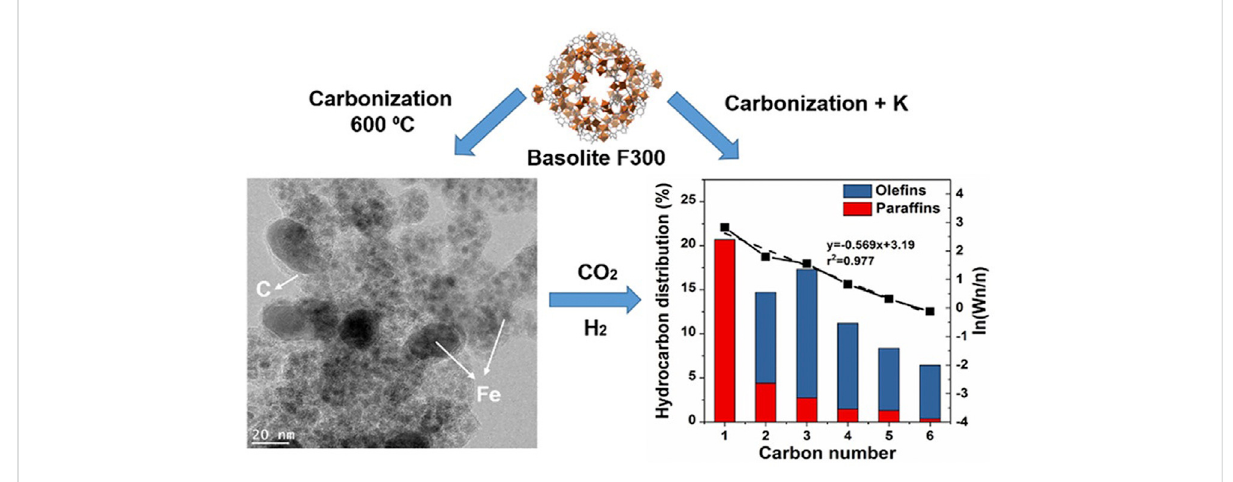
FIGURE 4 Morphological characterization and product distributions of the Fe MOF (metal-organic framework)-mediated catalyst (Ramirez et al.,